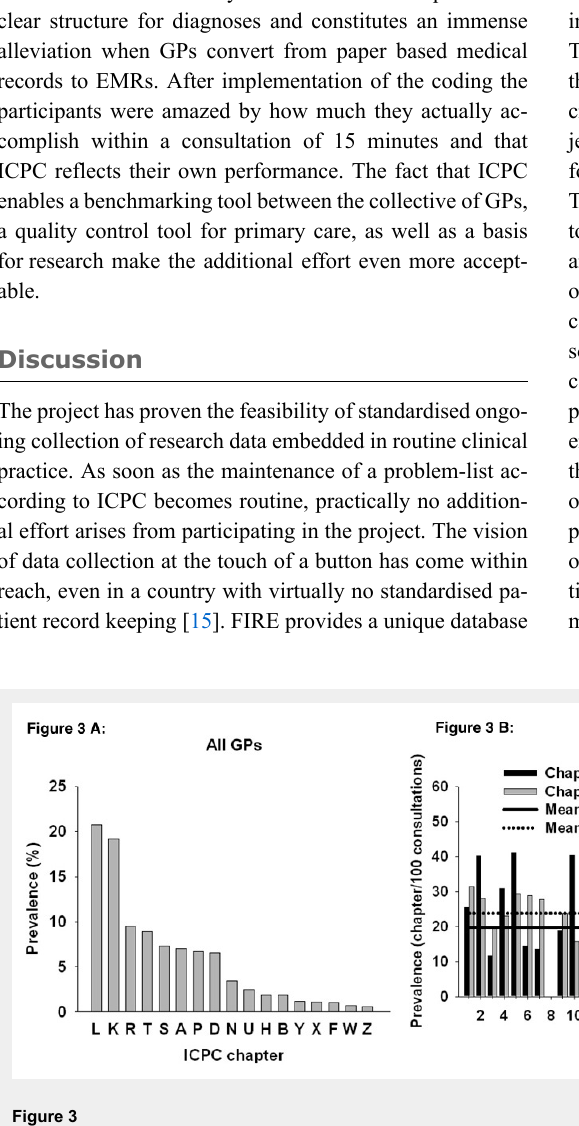
Frequency distribution of medical problems (%) on the y-axis according to ICPC-Chapters (x-axis) that resulted from physician patient